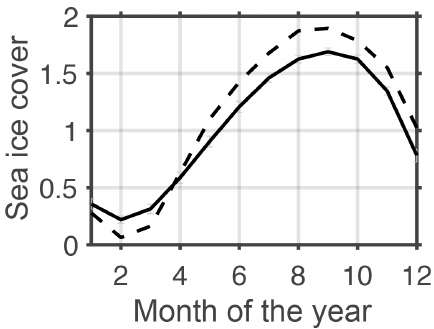
Figure 21. Simulated annual mean sea ice cover south of 40 ◦ S in units of 10 7 km 2 . The black (red) line refers to the reference (in- creasing wind) simulation.